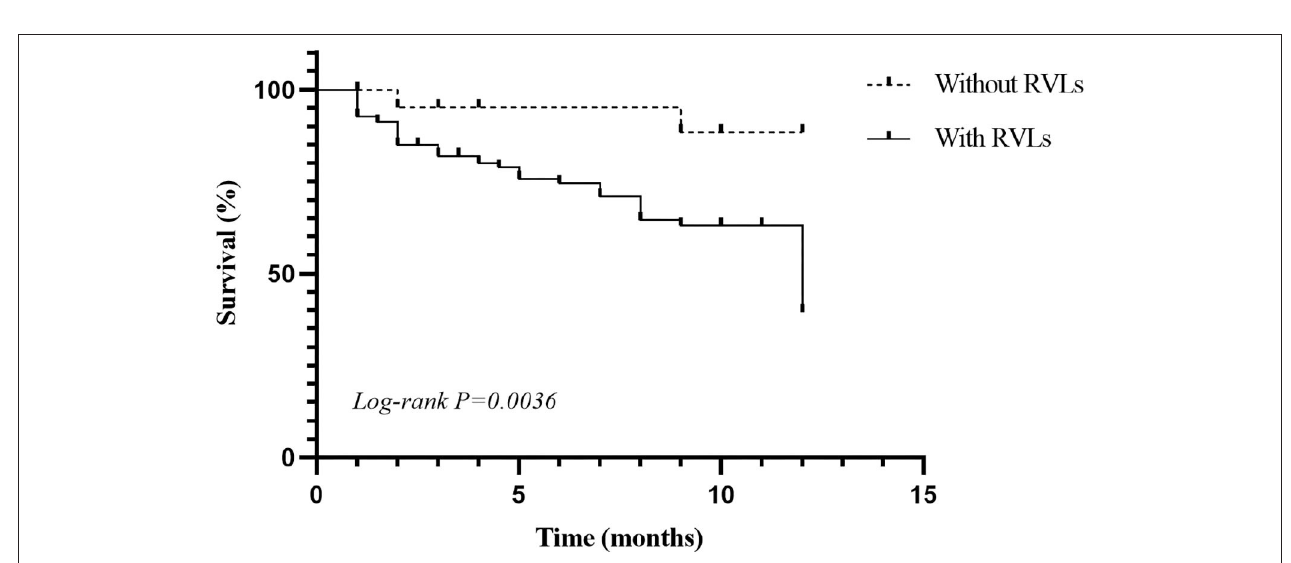
FIGURE 2 | The outcome of the patients in two groups after a 1-year follow-up.